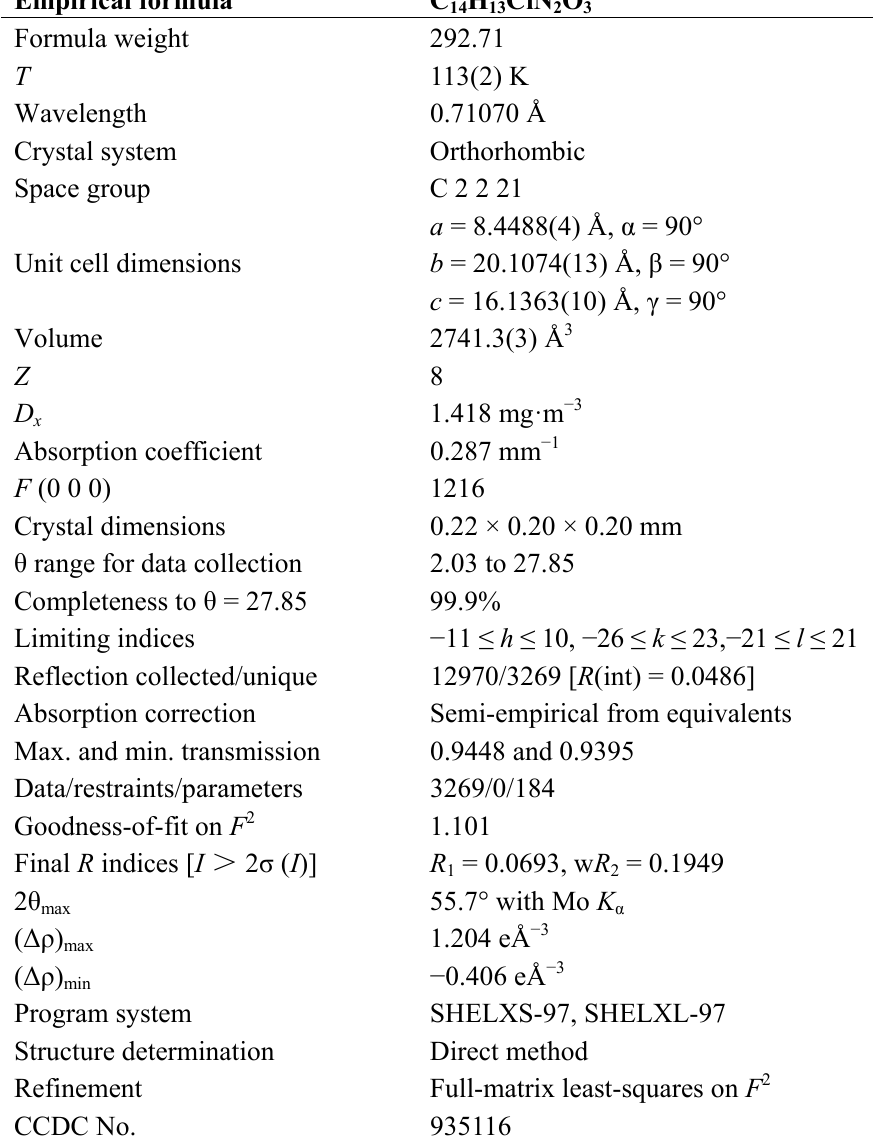
Table 1. Crystal and experimental data of compound III-3-2